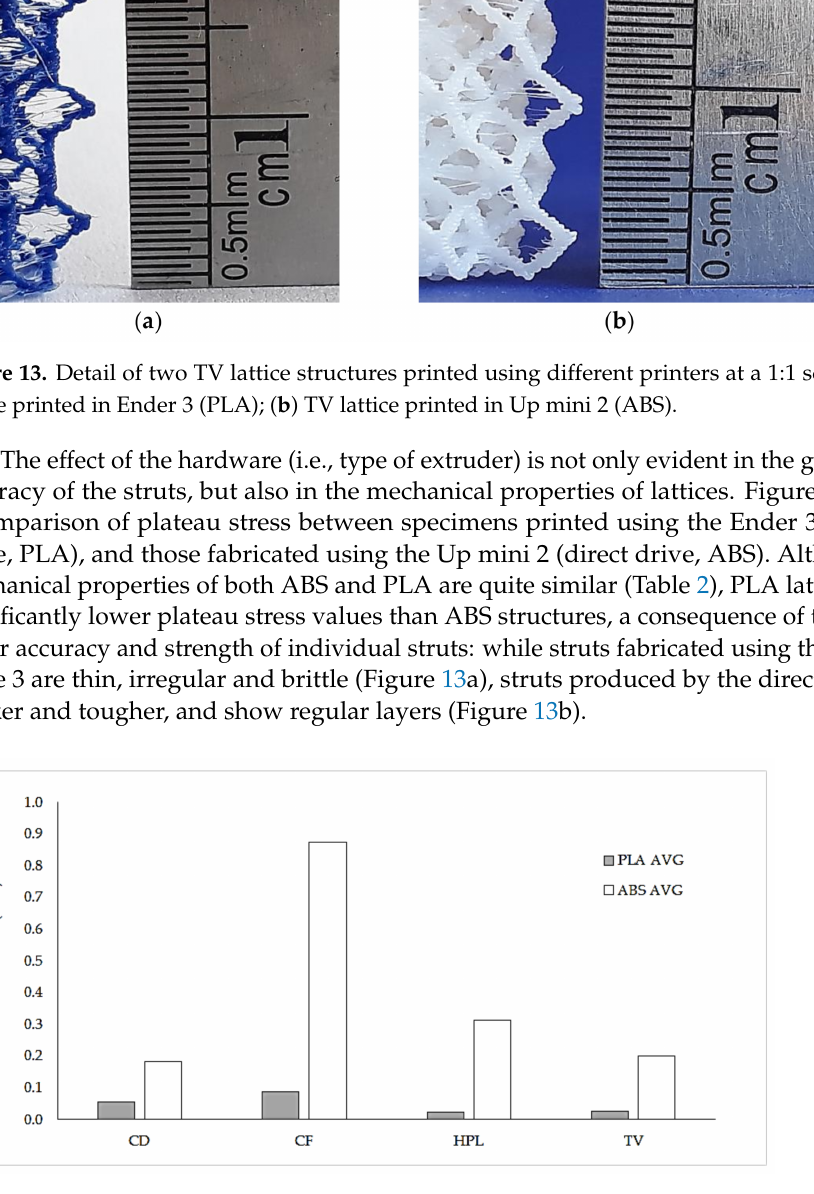
Figure 14. Comparison of plateau stress between PLA and ABS lattices (scale 1:1). PLA specimens were built using the Ender 3 (Bowden drive), while the ABS specimens were built using the Up mini 2 (direct